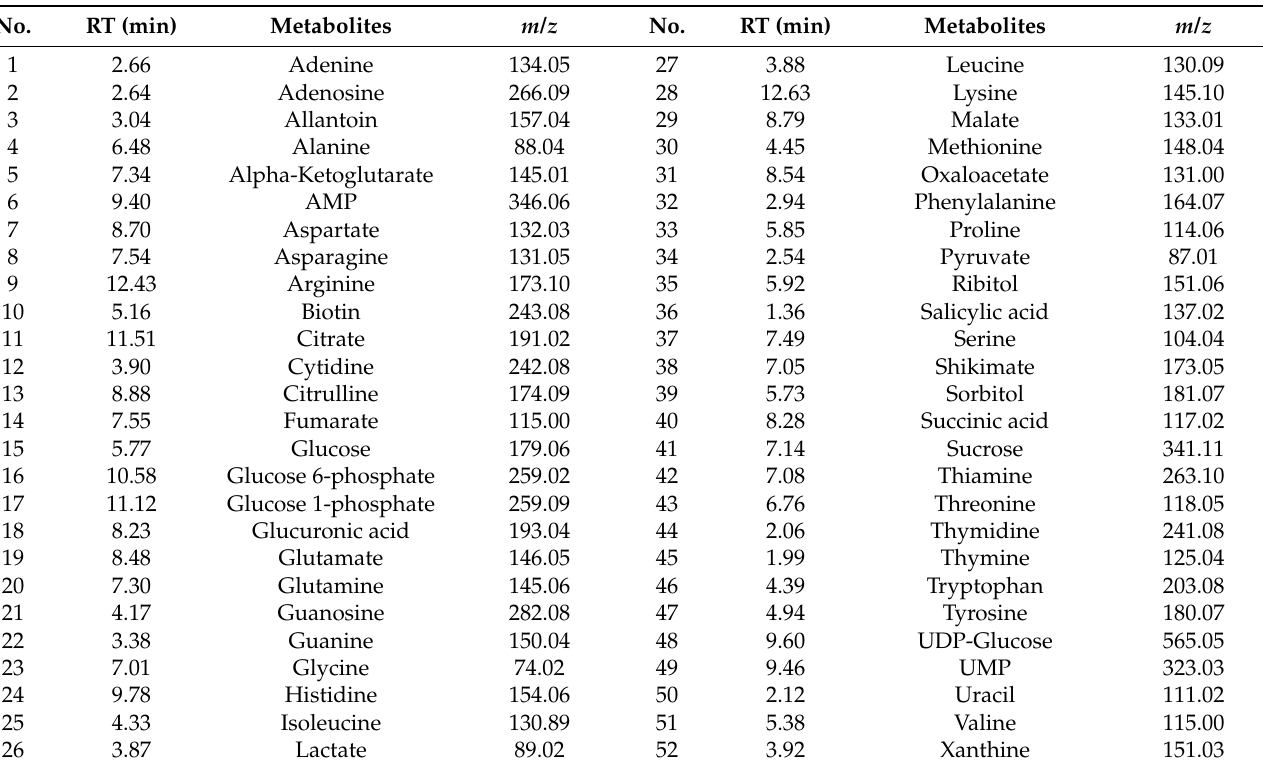
Table 1. Metabolites in plant leaf tissues for water treatment and 2 mM aspartate treatment of perennial ryegrass exposed to control temperature and heat stress